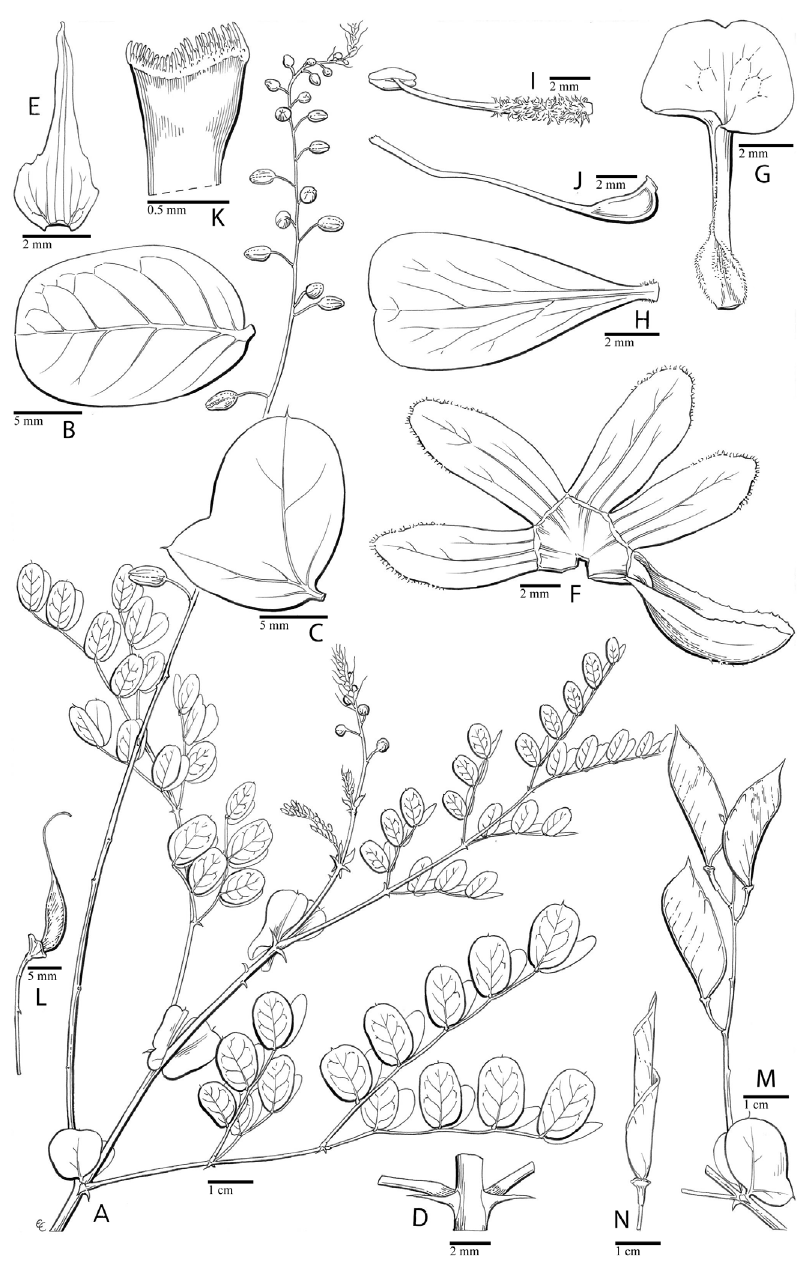
Figure 12. Denisophytum stuckertii (Hassl.) E. Gagnon & G. P. Lewis. A foliage and inflorescences B median leaflet undersurface C stipule D leaf rachis spines E bract F calyx opened out G median petal H lateral petal I stamen J gynoecium K stigma L developing ovary M infructescence, N single fruit valve after dehiscence. A, B, D–K from Renvoize et al. 3538 C, M from Venturi 7697 L from Ruiz et al. 10488c N from Aguilar 241. Drawn by Eleanor